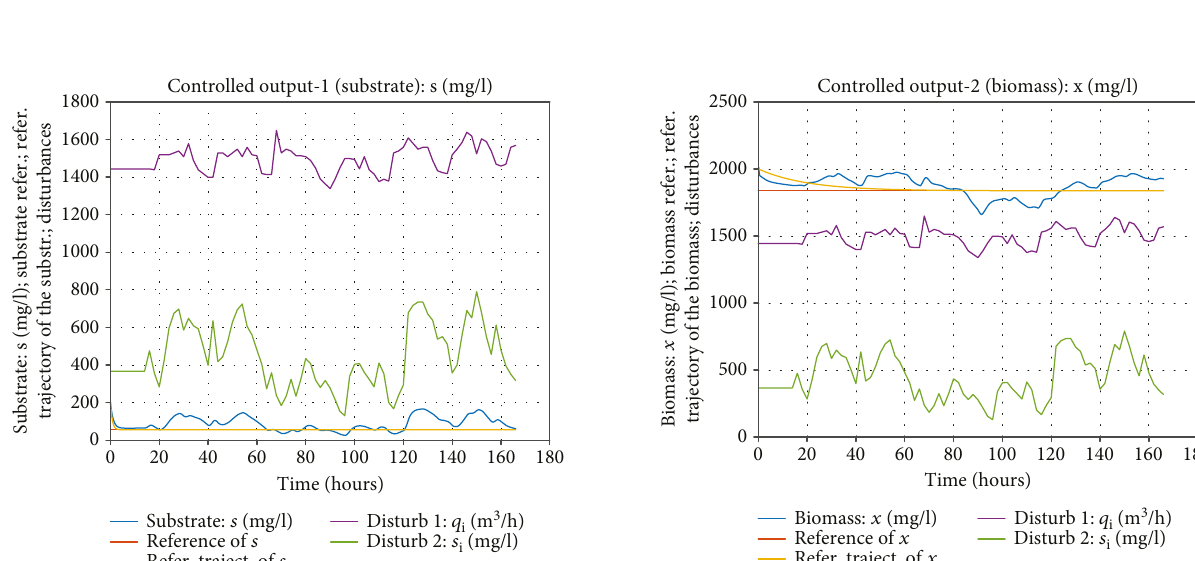
Figure 23: Control variables calculated by FMBPC and PID strategies (case C).